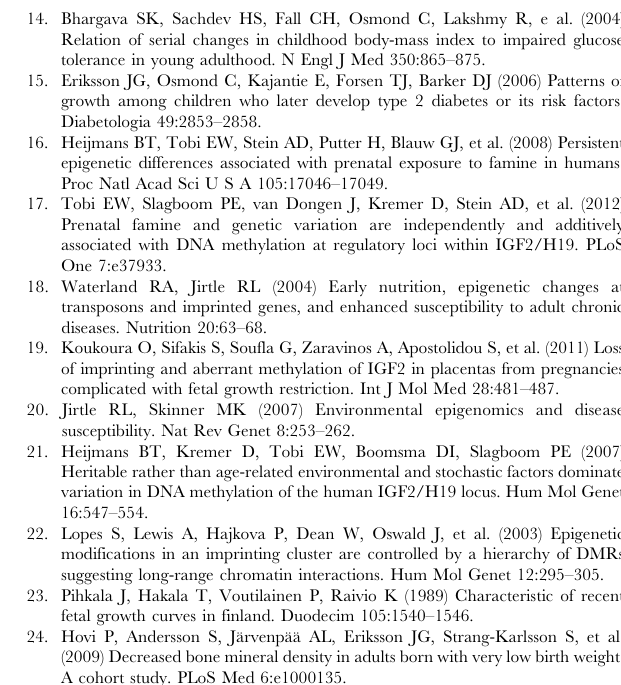
Table S1 Differences in methylation fractions at differ- ent IGF2AS and IGF2_05 CpG units between VLBW and control subjects by linear regression, and effects of covariates [B, 95% confidence interval (CI), and P] adjusted for in the